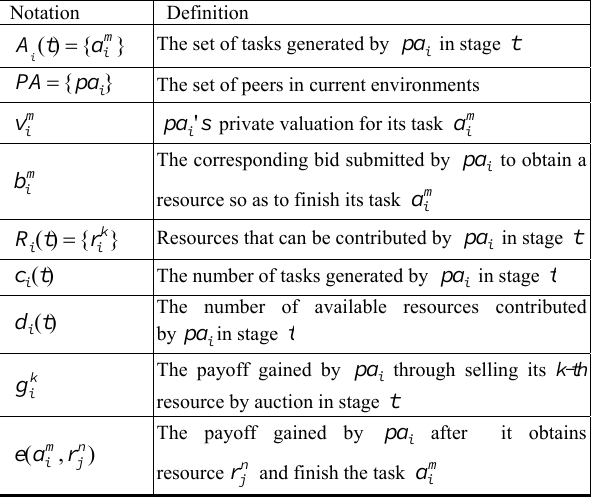
Table 1. Definitions of major